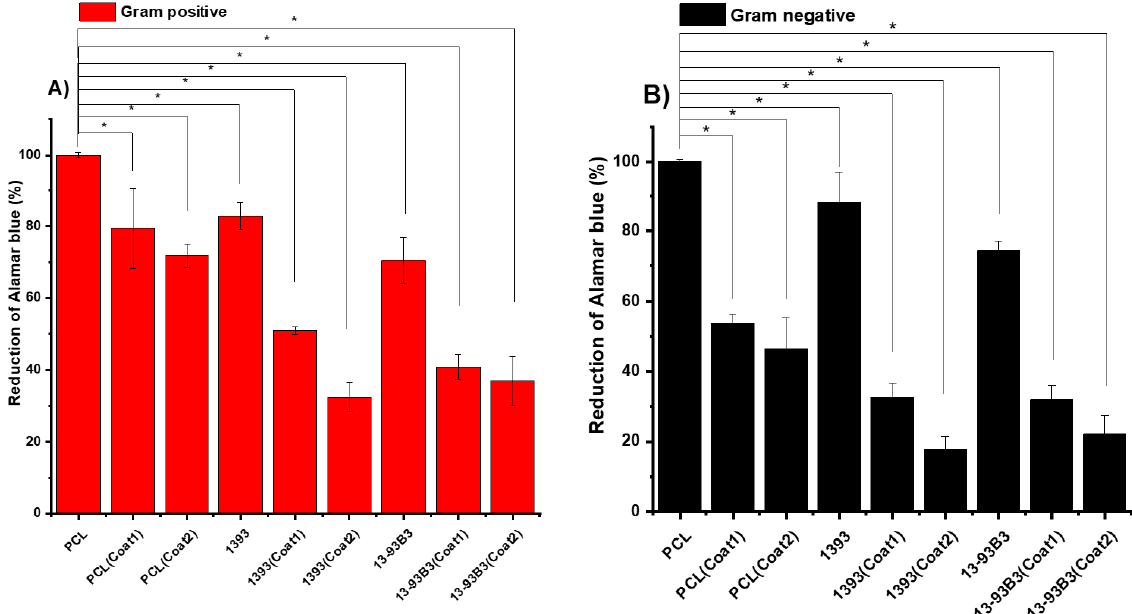
Figure 8. Reduction of Alamar blue after 24 h: ( A ) Gram-positive ( S. aureus ) and ( B ) Gram-negative ( E. coli ) bacteria, with p < 0.05 (*) considered statistically significant.